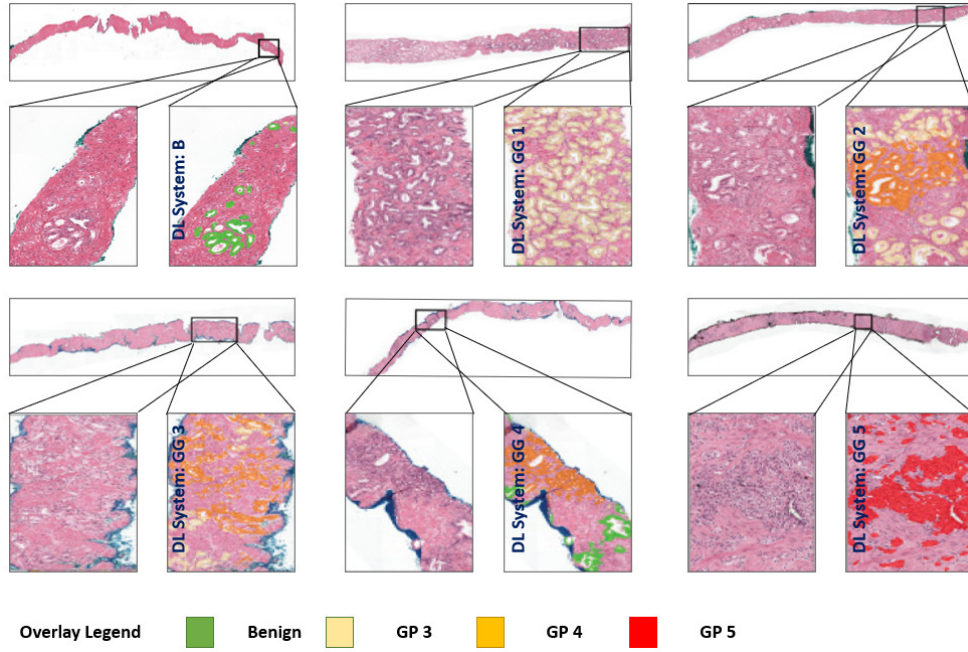
Figure 6. Examples of GG results from our system. In zoomed regions, system’s GP prediction is shown as an overlay on tissue; B (benign).